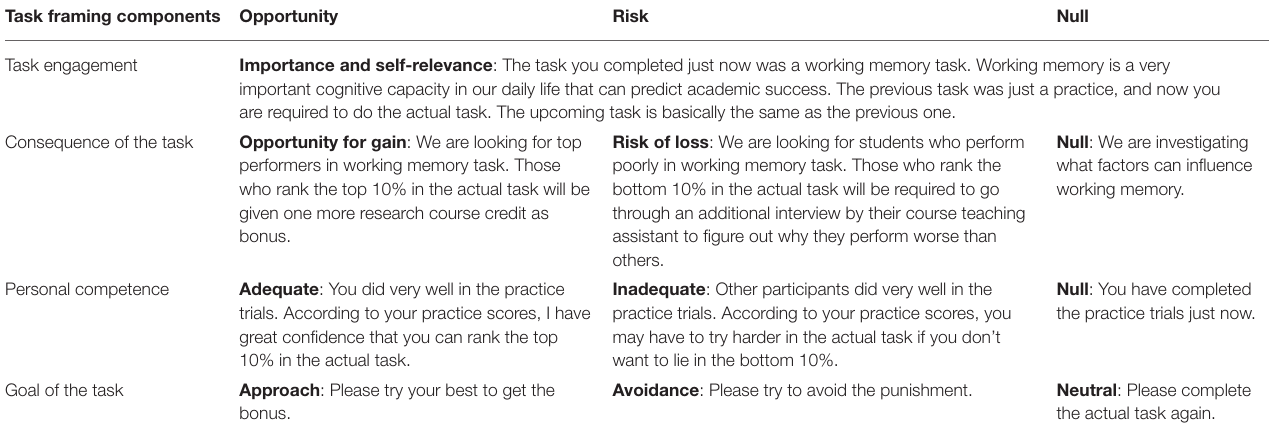
TABLE 1 | Instructions in three task framing